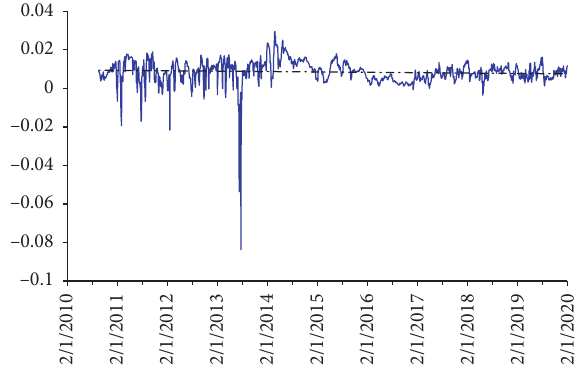
Figure 3: Interest rate risk premium from 2010 to 2020.